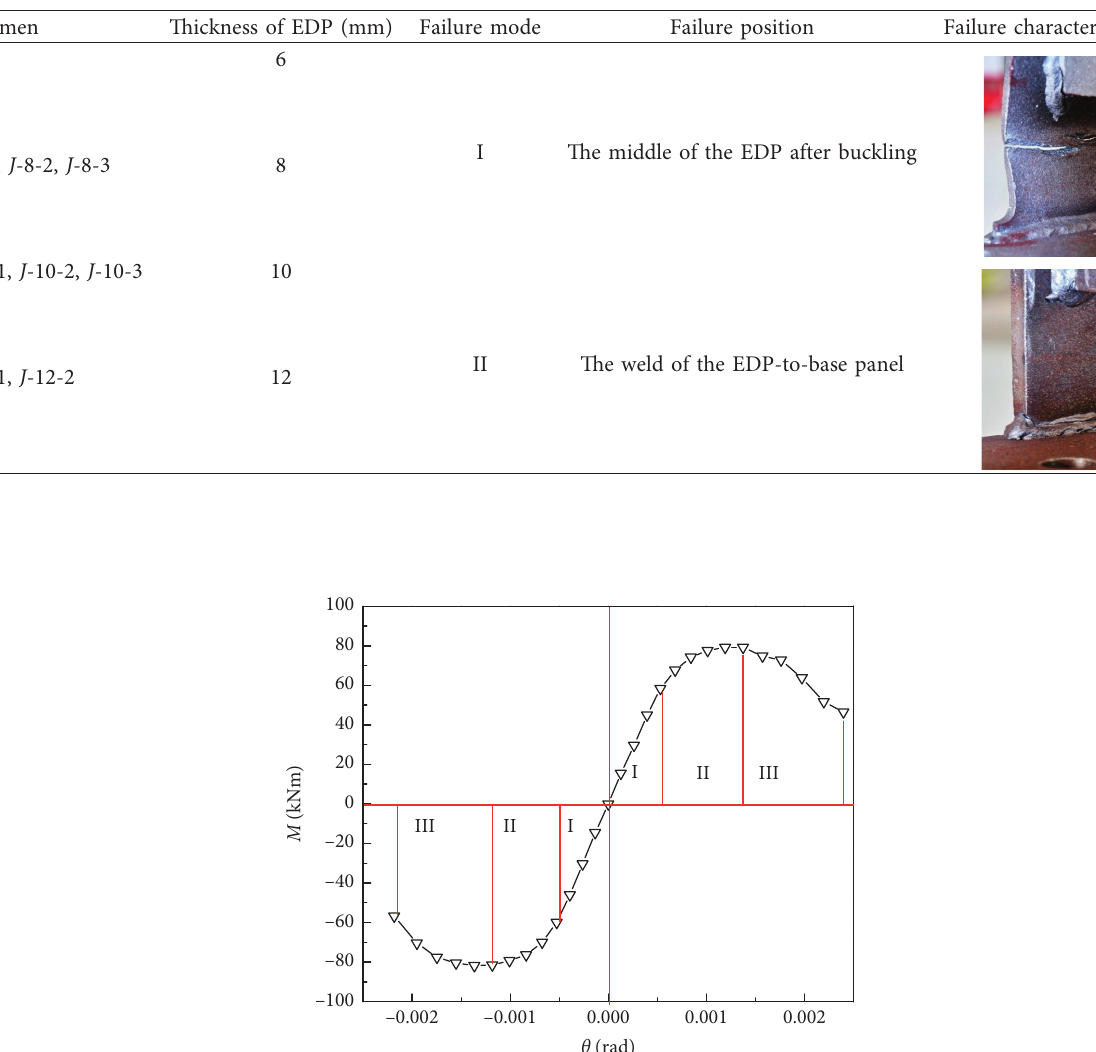
Figure 2: The energy-dissipation joint tests: details of the experimental specimen (a); schematic picture (b); loading regime of the test (c). Table 2: The experimental results of the energy-dissipation joint.